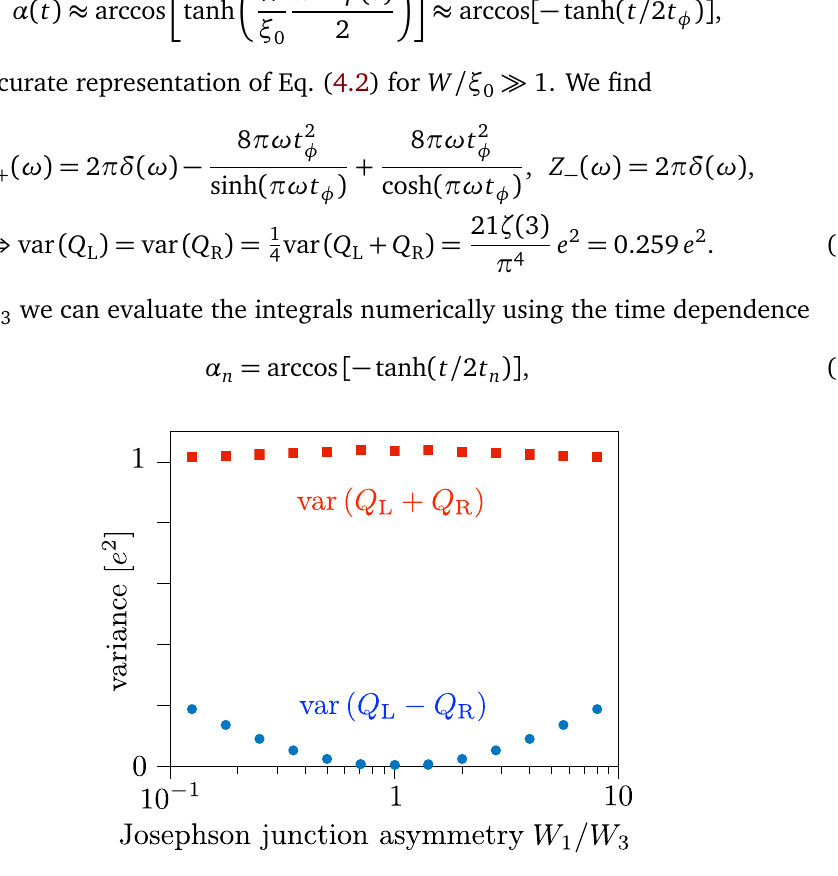
Figure 5: Variance of the sum and difference of the transferred charges upon fusion of the edge vortices in Josephson junctions J in the width of the injecting Josephson junctions J